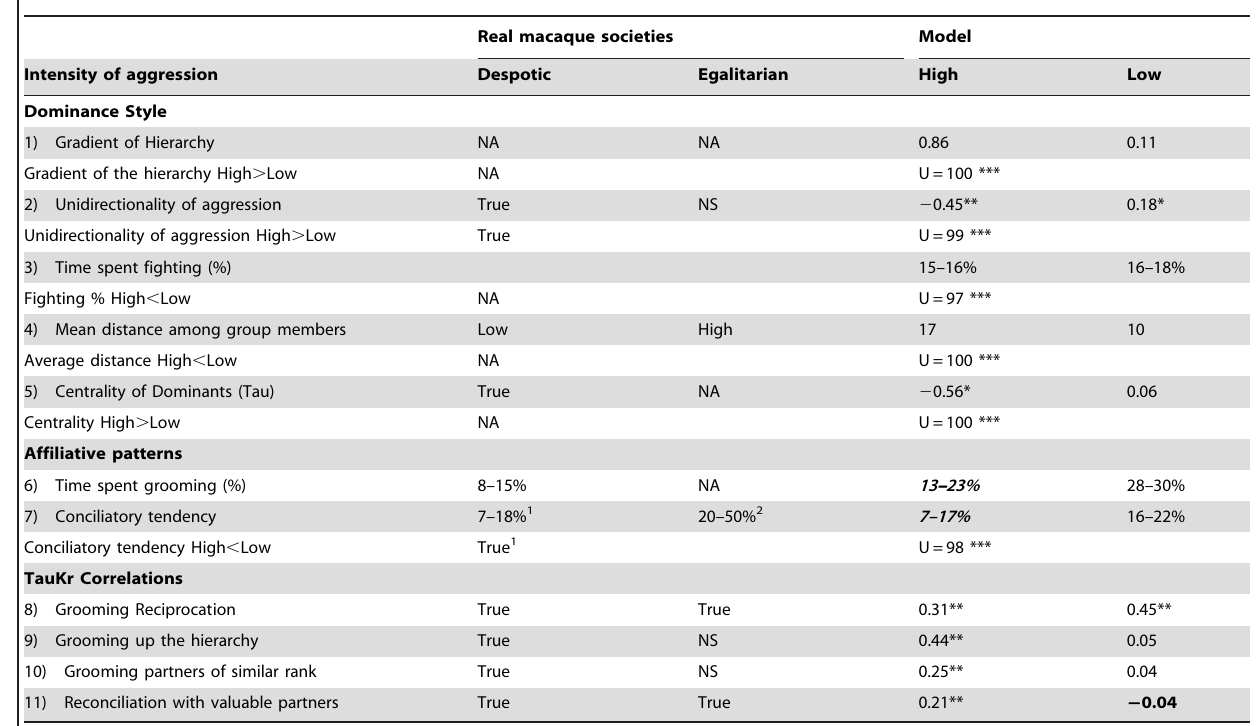
Table 4. Dominance style and affiliative patterns (for measurements see